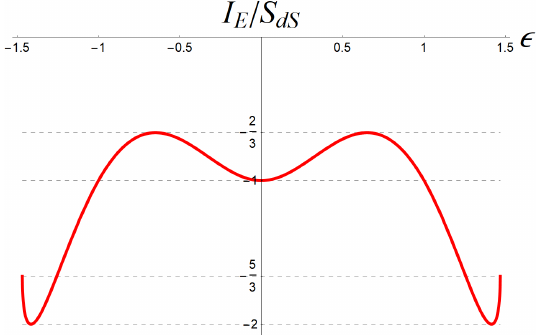
Figure 10: Euclidean action I Empty de Sitter is a minimum and Nariai a maximum of the action, and there is an additional global minimum at | ε | =